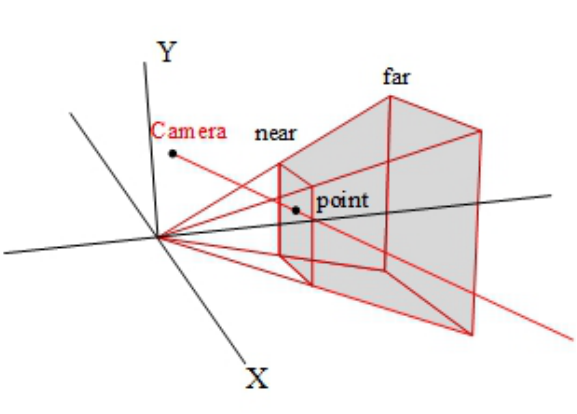
Fig. 8. Schematic diagram of Raycaster ray